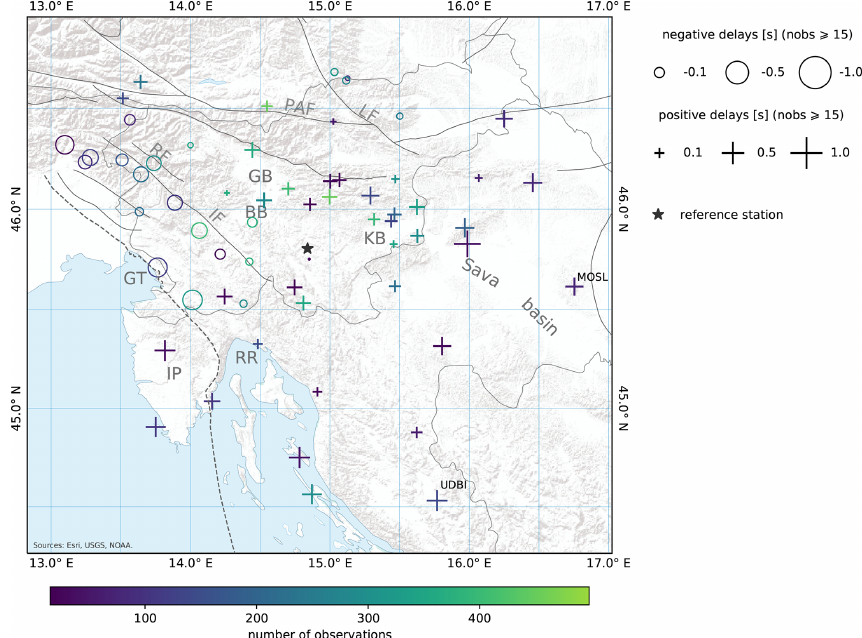
Figure 7. P-wave station delays computed for the MPS velocity model. Station delays are shown only for stations with at least 15 observa- tions. The black star marks the reference station (see the main text for details). Refer to Fig. 1 for the list of geographical names and faults. A shaded relief is shown in the background (Esri, USGS, NOAA).